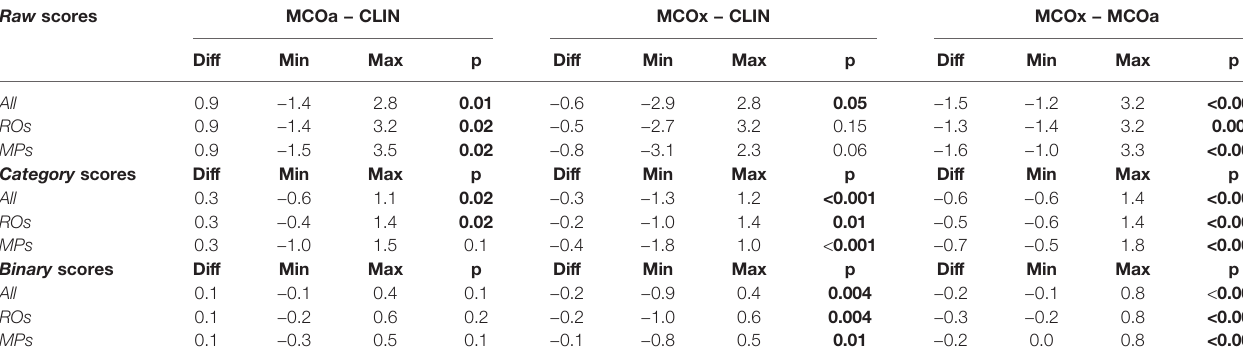
TABLE 1 | Median differences in raw, category, and binary scores assigned by the fi ve ROs, four MPs, and all nine observers combined (All). Raw scores MCOa − CLIN MCOx −